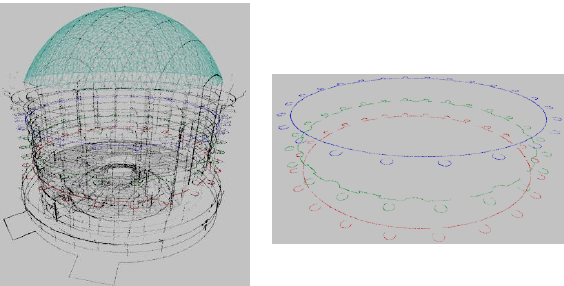
Figure 8: Segmented point cloud and horizontal cut sections imported into BIM software